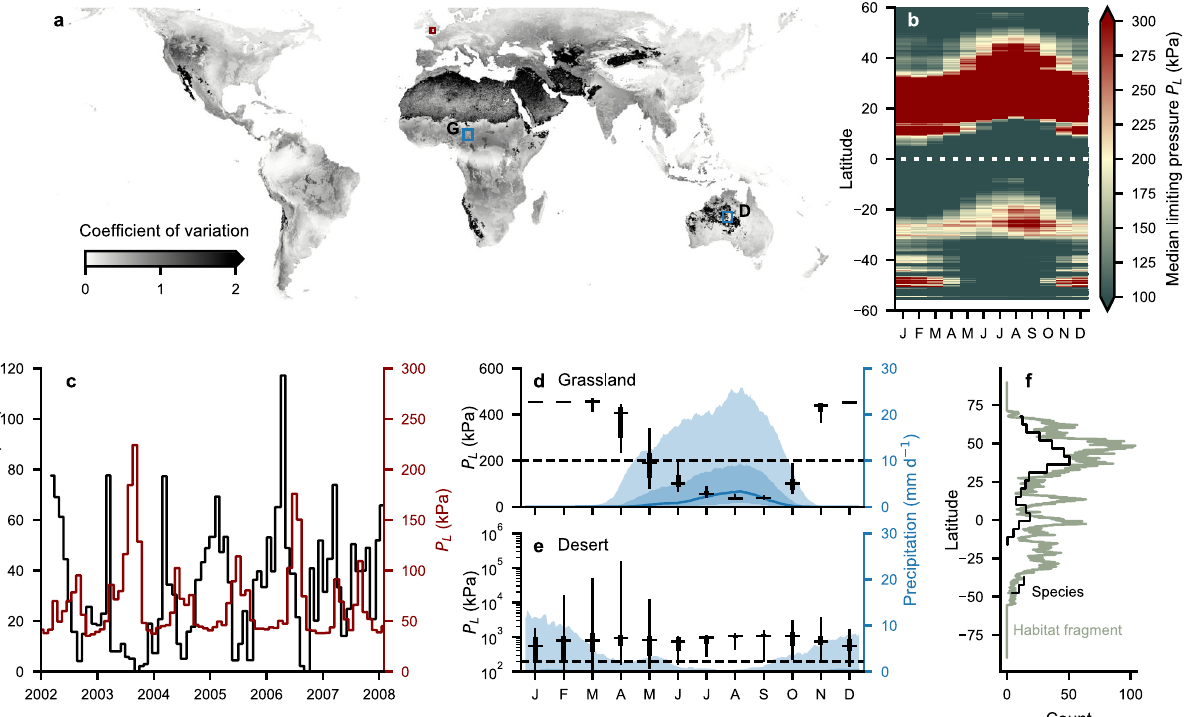
Fig. 4 Temporal windows of potential earthworm burrowing activity. a Global map of temporal hydromechanical variations (coef fi cient of variation of limiting pressures). b Median earthworm limit pressures across latitudes for a climatic year. c Time series comparison of modeled cavity expansion limiting pressure (red) with measured earthworm abundance (black). Earthworm abundance was measured monthly in the New Forest, Hampshire UK (5.9°N, − 1.6°E, 34 ) over six consecutive years. d , e Median climatic limiting pressures (boxes indicate central 50 and 90% of values) required to burrow through the soil are associated with mean daily precipitation 48 (blue line and shading; 30 days running median and central 50 and 90% of values) for ( d ), a grassland ( g : 9.55°N, 14.65°E) and ( e ), a desert ( d : − 22.95°N, 132.95°E) as indicated in ( a ). The maximum radial earthworm pressures P w (dashed line) are shown. Soil limit pressures are reported for the topsoil (0 – 7 cm) and are assumed to represent the driest part of the soil pro fi le. f Habitat fragmentation based on habitable regions is plotted in comparison with species richness 14 results for different latitudes.